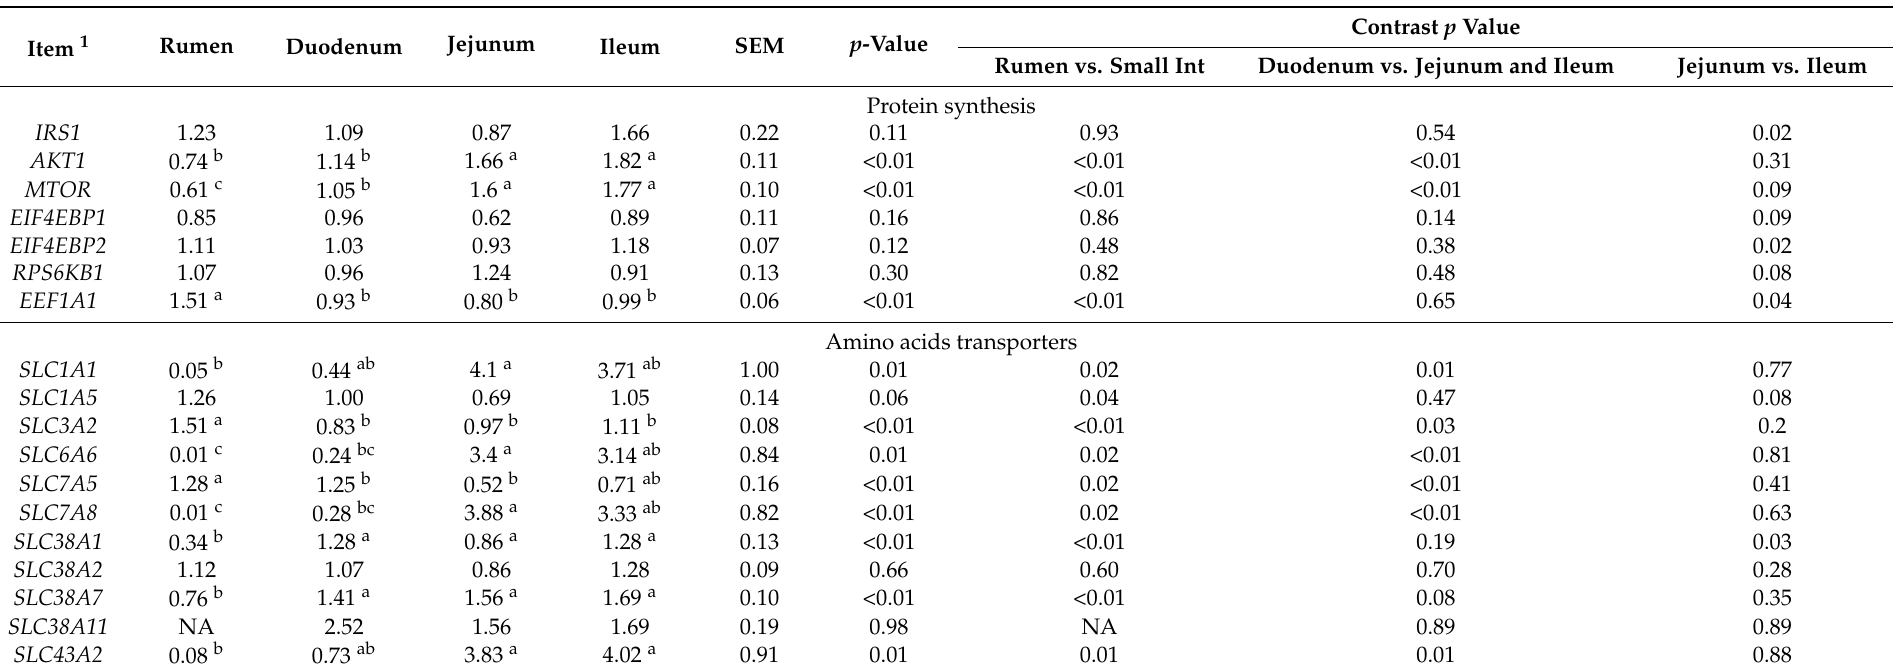
Table 2. Least-squares means, pooled SEM, and p -values for the mRNA abundances of target genes associated with protein synthesis and amino acid transport in tissue harvested from the rumen, duodenum, jejunum, and ileum from lactating Holstein cows ( n =